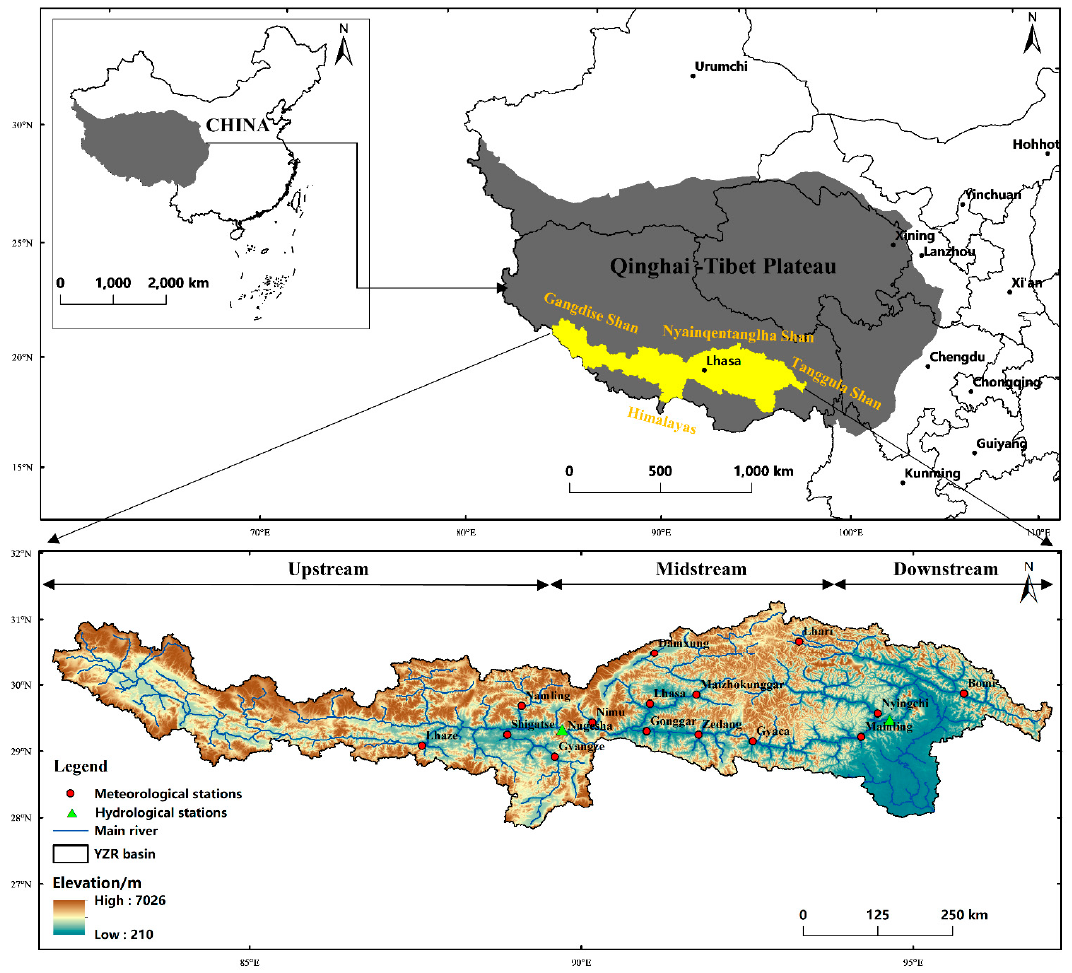
Figure 1. Location of the Yarlung Zangbo River basin and distribution of the hydro-meteorological stations.